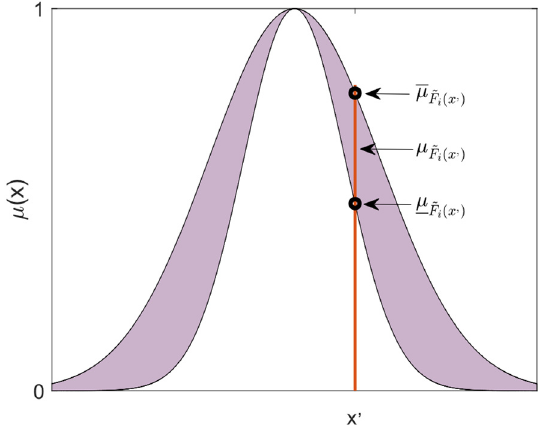
Figure 1. An interval type-2 fuzzy membership function.